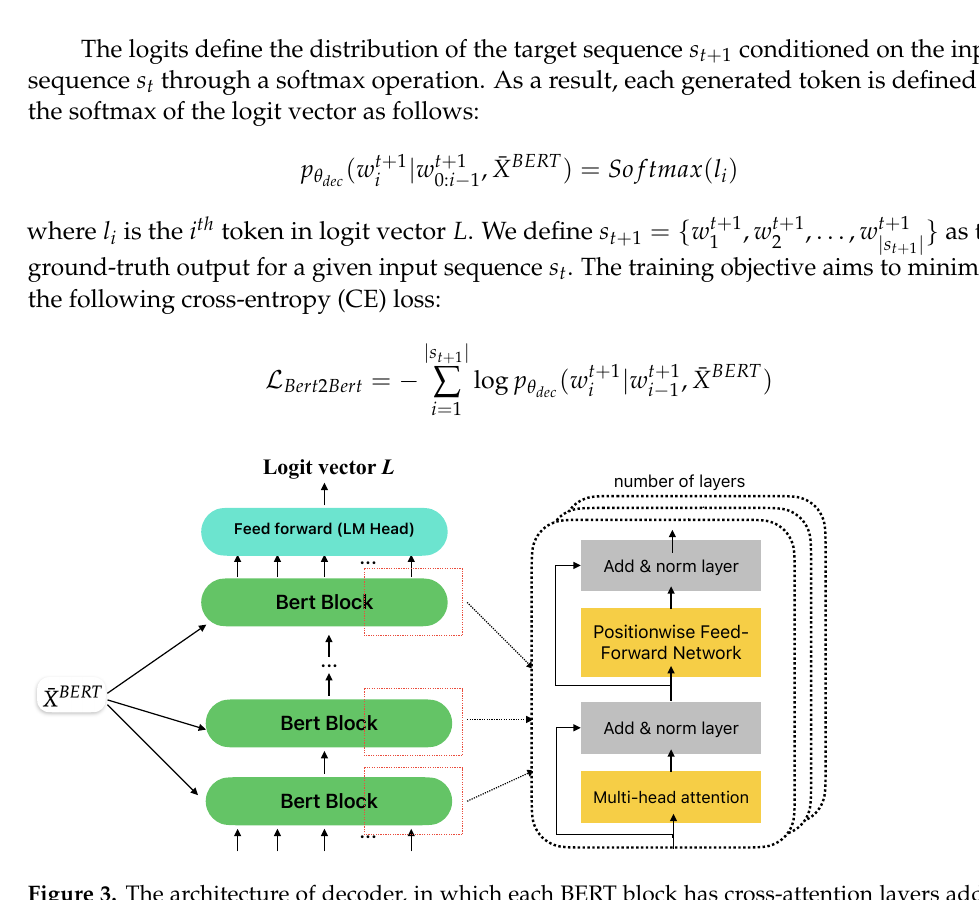
Figure 3. The architecture of decoder, in which each BERT block has cross-attention layers added between the multi-head attention and the feed-forward